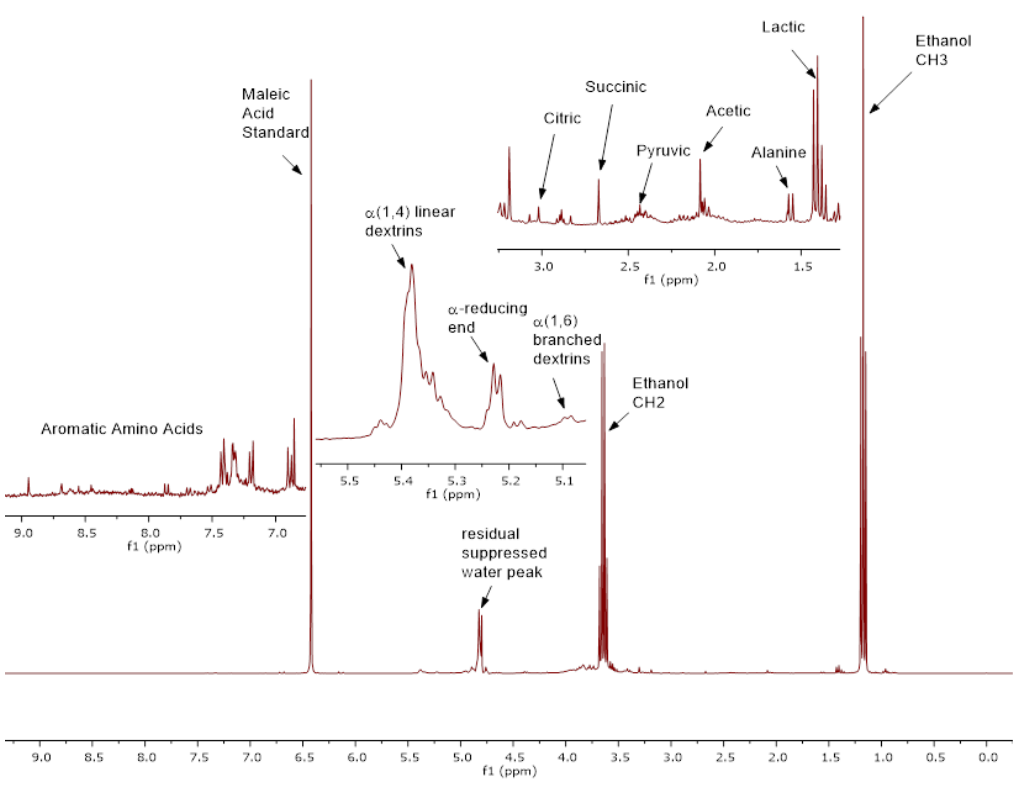
Figure 1. Proton NMR spectrum of an IPA style beer (sample 2). Table 3. Concentrations of organic compounds in beer determined by